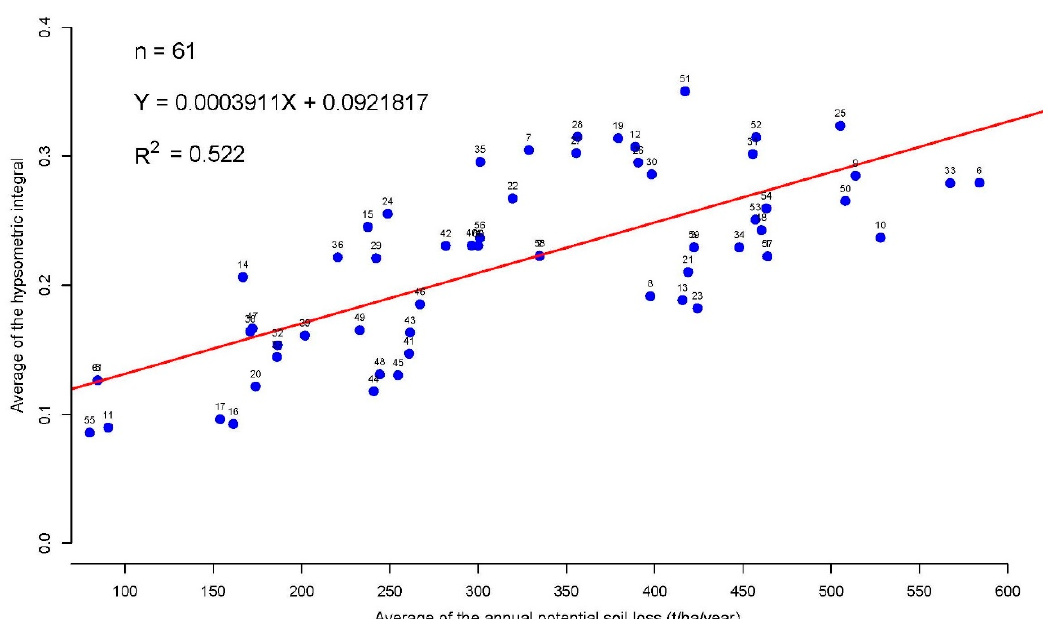
Figure 10. Relationship between average of potential erosion (i.e., R*K*LS product) and the average of the HI in the KhRB, in individual subbasins.